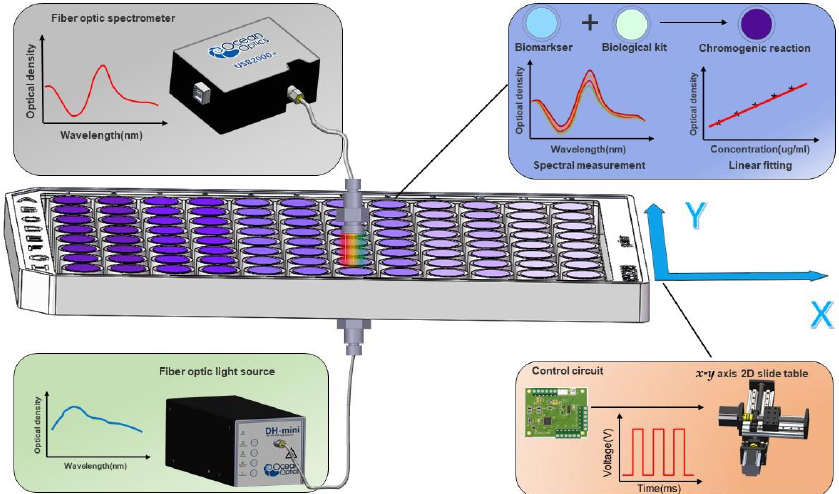
Figure 1. Mechanism of the automated high-throughput efficient microplate reader (AHTEMR) biosensing system. The AHTEMR consists of a micro fiber optic spectrometer, a light source, an x - y axis 2D Slide table, and a computer with LabVIEW software. Based on the self-designed master circuit and PWM signal, the x - y axis 2D slide table carrying the micro-hole plate can be precisely controlled to complete an accurate displacement in the plane.